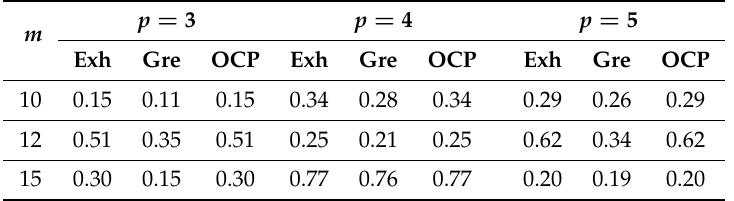
Table 2. Optimal Chernoff Distances of Three Methods.